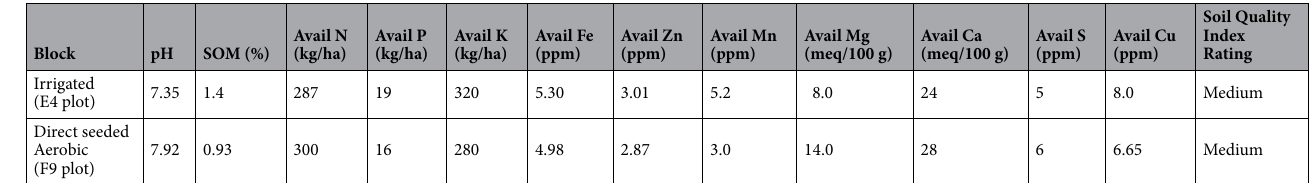
Table 2. Soil Characteristics of irrigated and aerobic block of IIRR Farm,